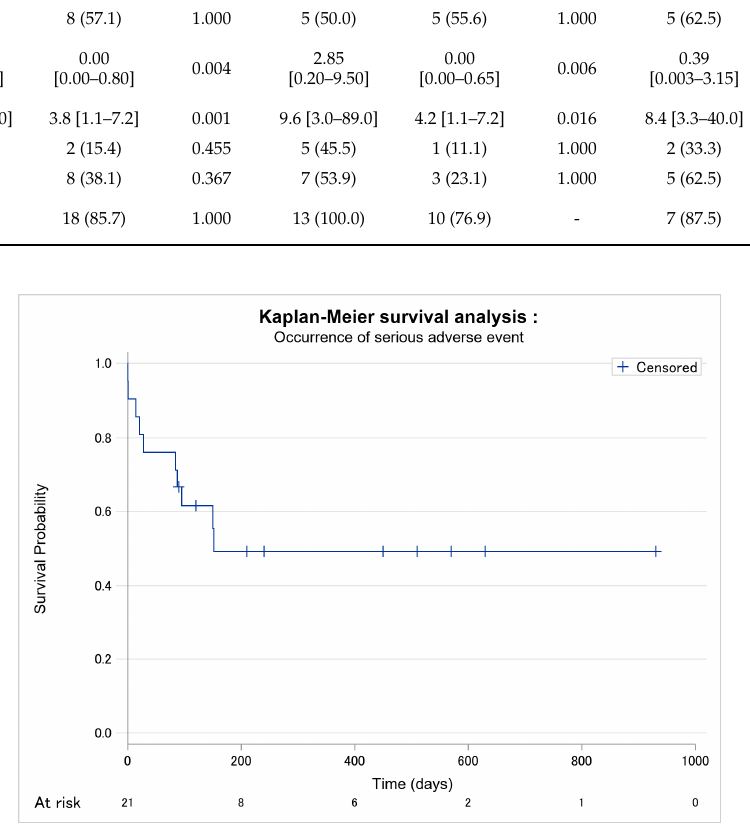
Figure 3. Kaplan–Meier survival analysis of occurrence of severe grade III–IV adverse event among the 21 patients. No missing data.